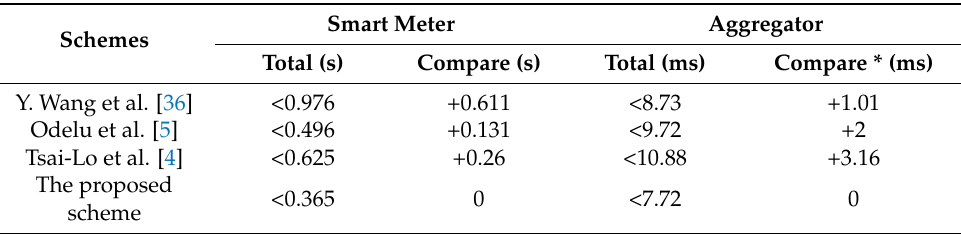
Table 16. Computation cost at the authentication phase.